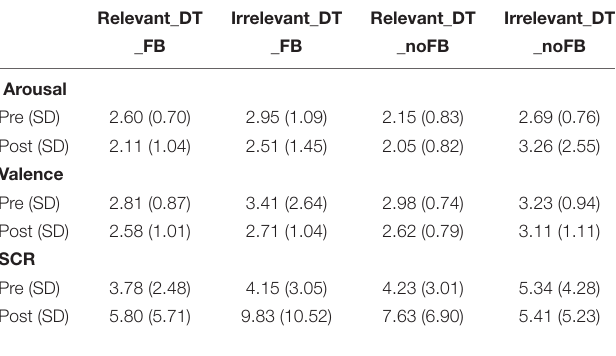
TABLE 2 | Generalization indices for arousal and valence ratings as well as skin conductance responses, separately for each training group and generalization pre- and